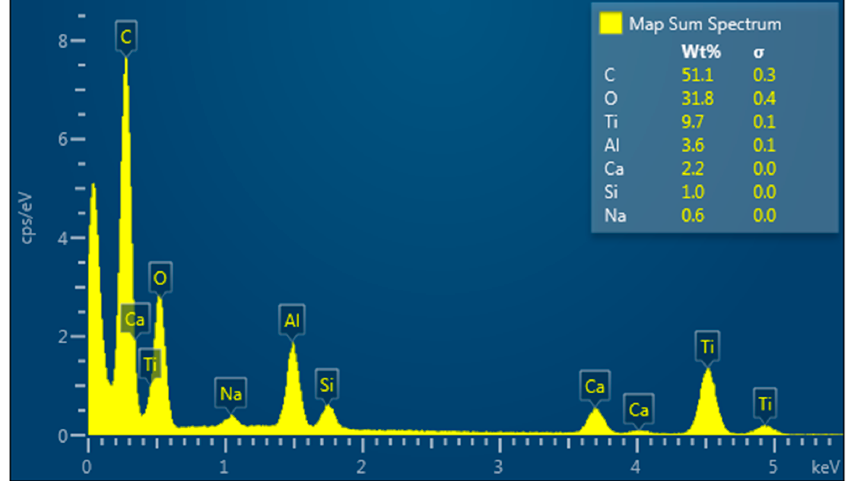
Figure 4. Specimen composition was characterized through energy dispersive X-ray (EDX) analysis.